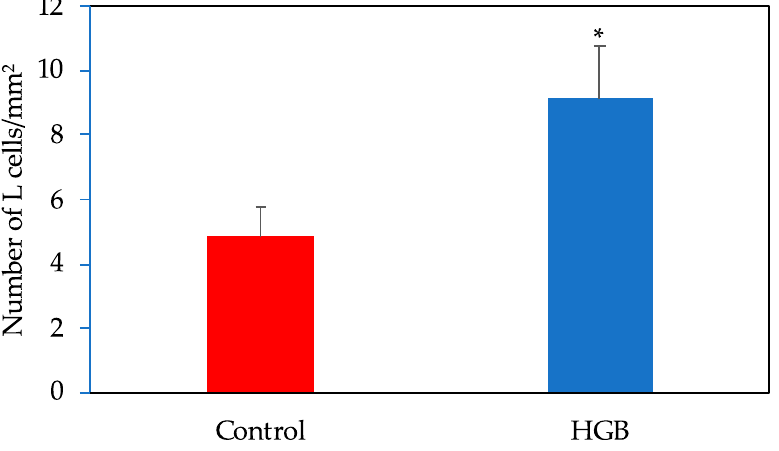
Figure 4. Number of L cells in the ileum. Data are shown as mean ± standard error of the mean (SE). * Significantly different from the control group ( p < 0.05). HGB; high β -glucan